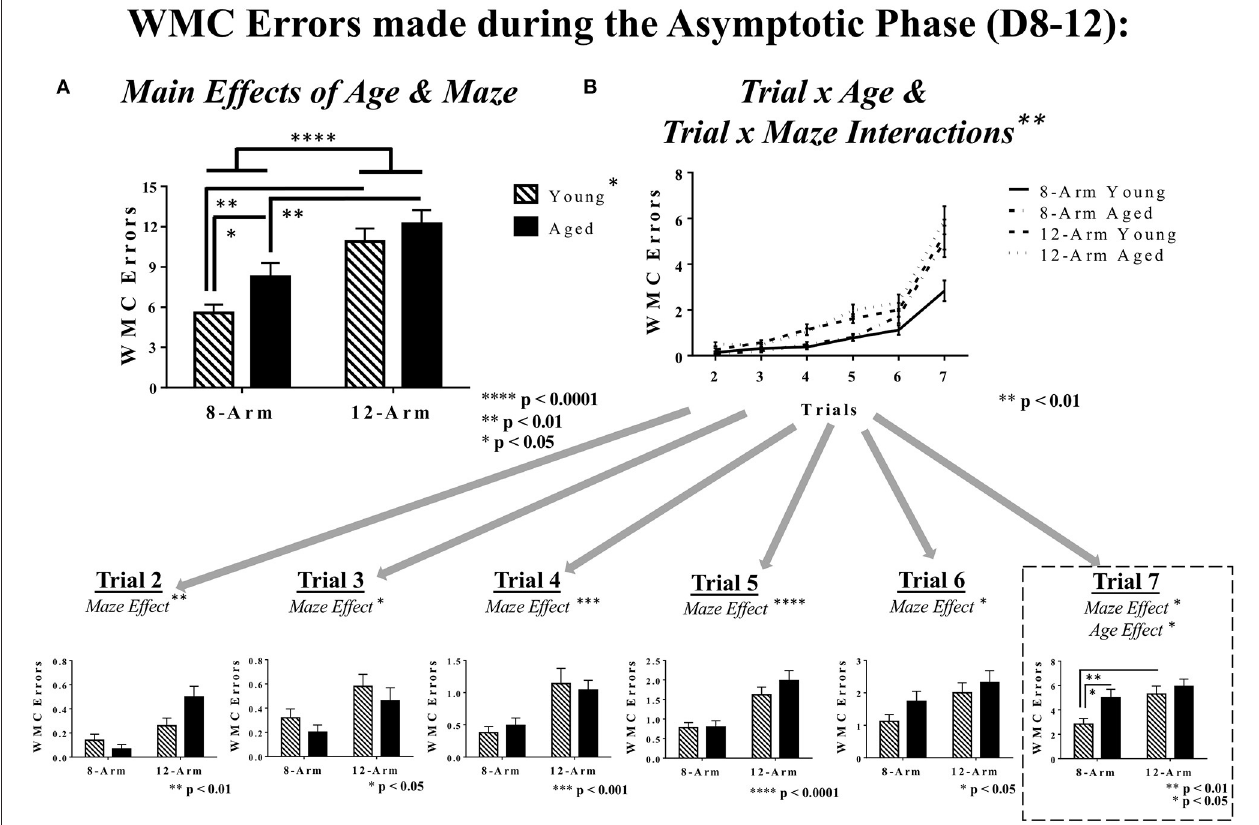
FIGURE 4 | WMC errors during the Asymptotic Phase of WRAM testing. (A) WMC errors for the Asymptotic Phase of WRAM testing (Days 8–12). With an effect of Maze and an effect of Age, it was found that within the 8-Arm WRAM there was an effect of Age, but not for the 12-Arm WRAM; notably distinct from the Acquisition Phase, both young and aged rats tested on the 8-Arm WRAM performed better their counterparts tested on the 12-Arm WRAM. (B) Working memory performance as assessed via WMC errors made across all testing trials (Trials 2–7). At the highest working memory load (Trial 7), there was a main effect of Maze and a main effect of Age, where aged rats performing on the 8-Arm WRAM made more errors than their younger counterparts, and the rats performing on the 12-Arm WRAM did not differ by age. Additionally, there was an effect of Maze for young rats exclusively, where young rat performance on the 8-Arm WRAM was better than that of the 12-Arm WRAM, with no effect of Maze for aged